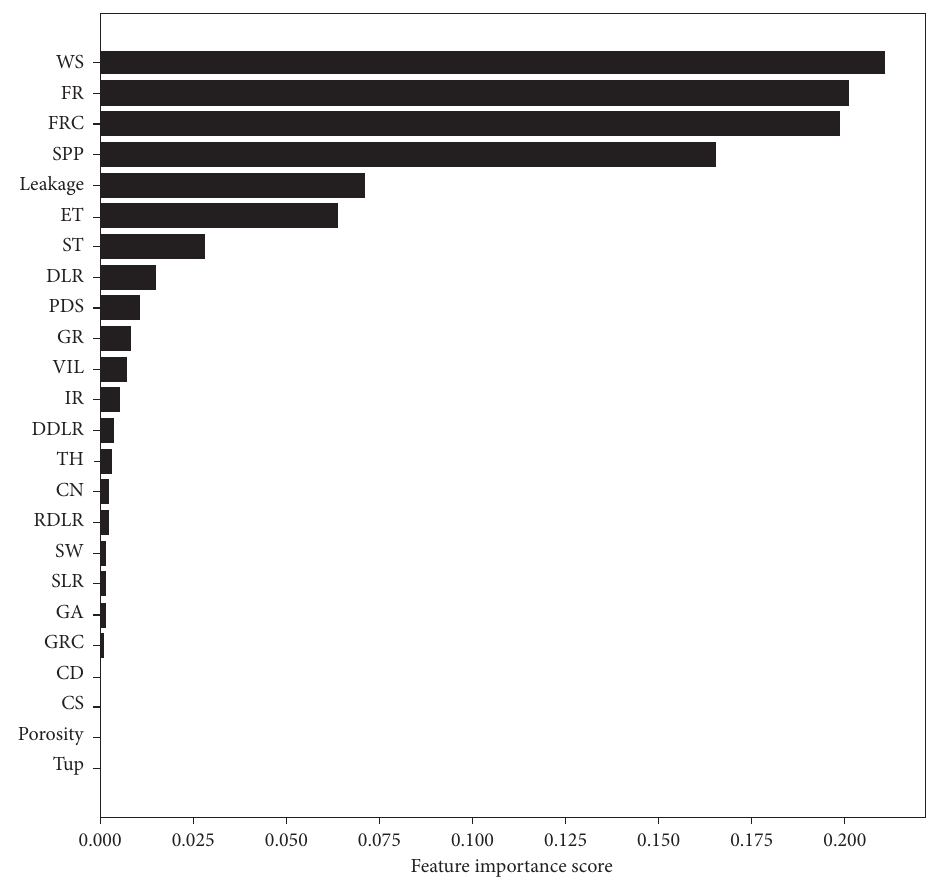
Figure 4: Xgboost feature importance